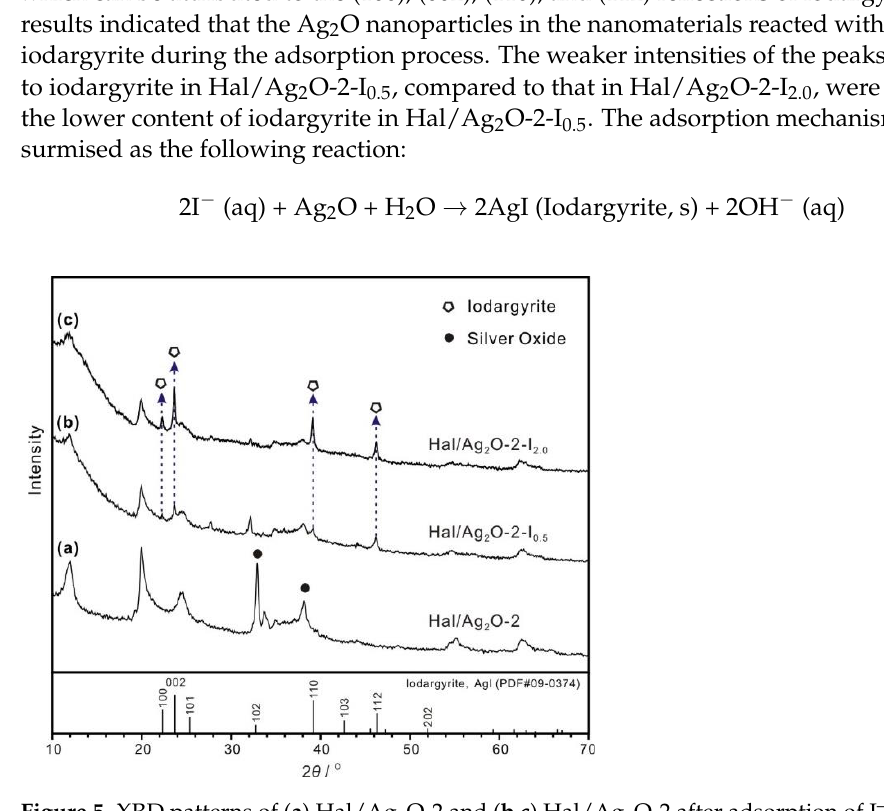
10 of 13 Table 2. Comparison of adsorption capacities of different adsorbents for I – . Adsorbents